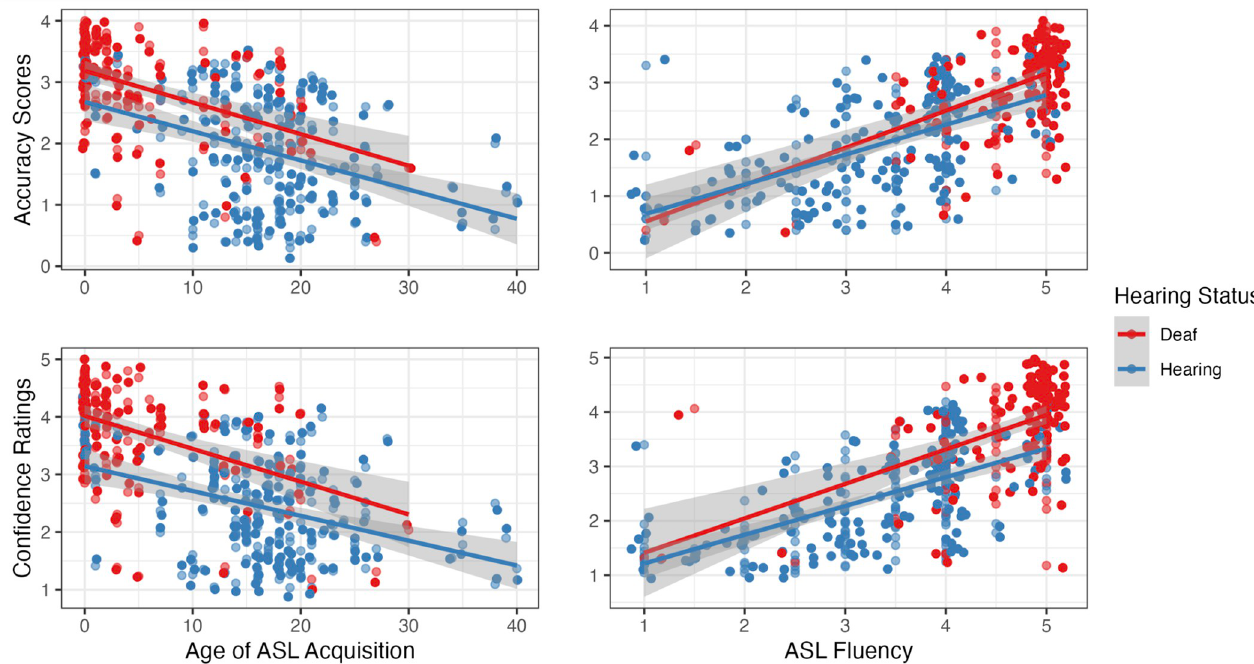
Fig 5. Correlation plots that show the relationship between overall accuracy scores (top panel) and confidence ratings (bottom panel), with the age of ASL acquisition (left panel) and self-rated ASL fluency (right panel). Colors denote the Deaf and Hearing groups. Each individual datapoint is transparent so overlapping datapoints are shown with greater opacity. A small amount of horizontal jitter has been added to ease visualization.